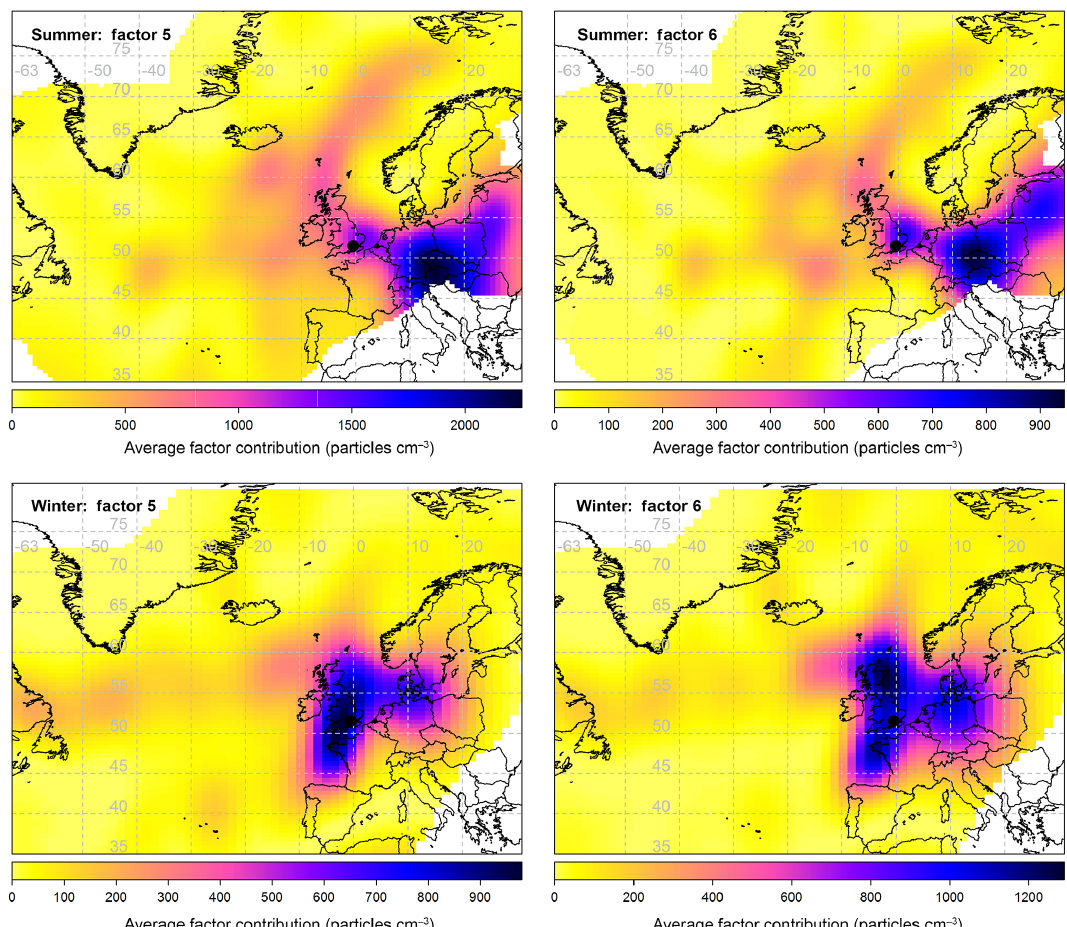
Figure 7. CWT maps of the secondary aerosol-related factors for both the seasons. Map scales refer to the average factor contributions to the total variable